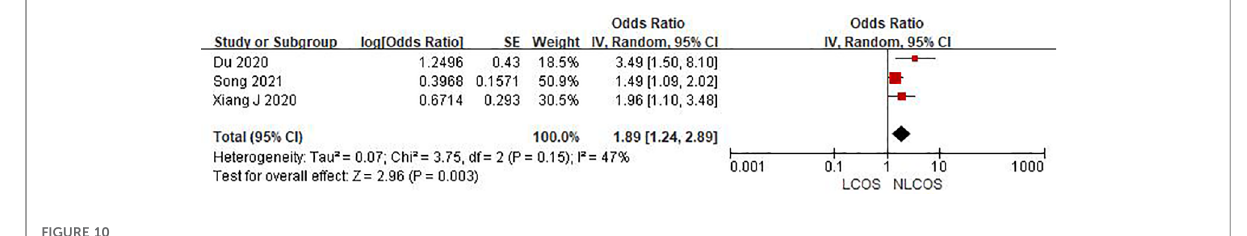
FIGURE 10 Postoperative residual shunt forest plot.